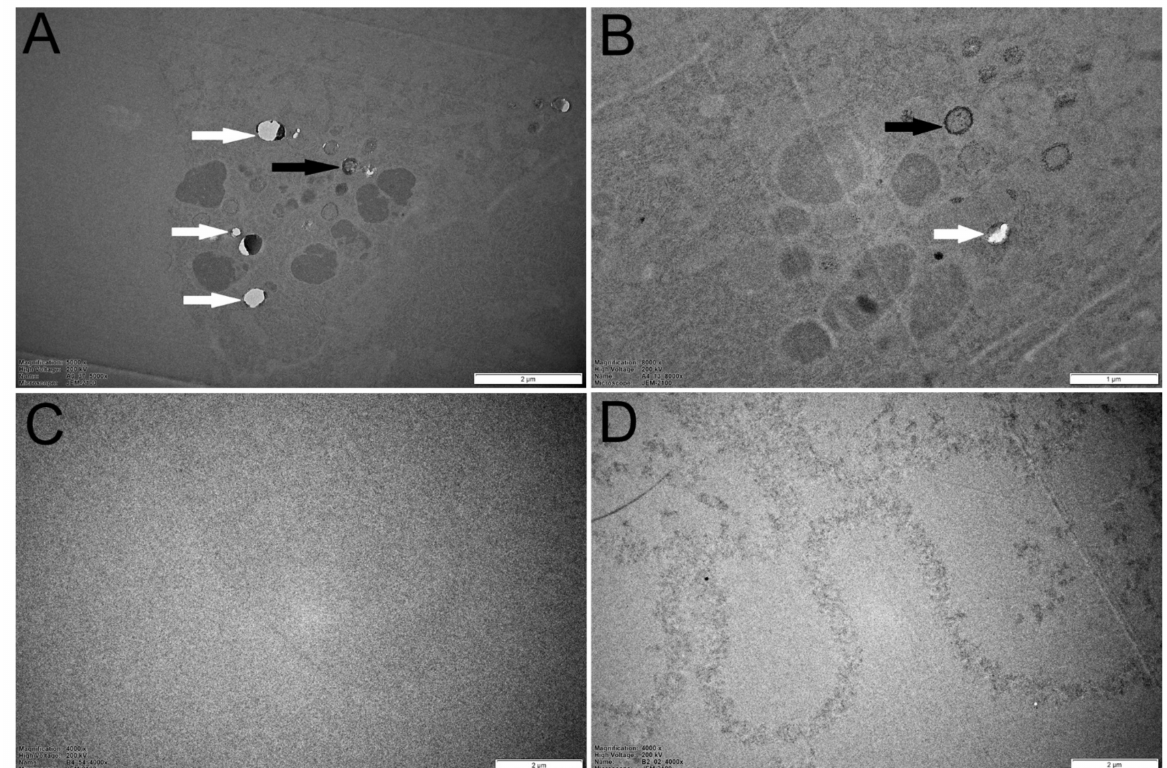
Figure 6. TEM images captured from the midgut tissues from the Vespula vulgaris workers captured in the area close to the smelter classified as the polluted zone ( A , B ) and Nakkila area classified as the reference zone ( C , D ) in 2019. The white arrows show the shiny metal particles revealed with the EDX technique. The black arrows show particles already encapsulated with melanin pigment. The quality of the images was affected by the inability to stain samples because of the EDX